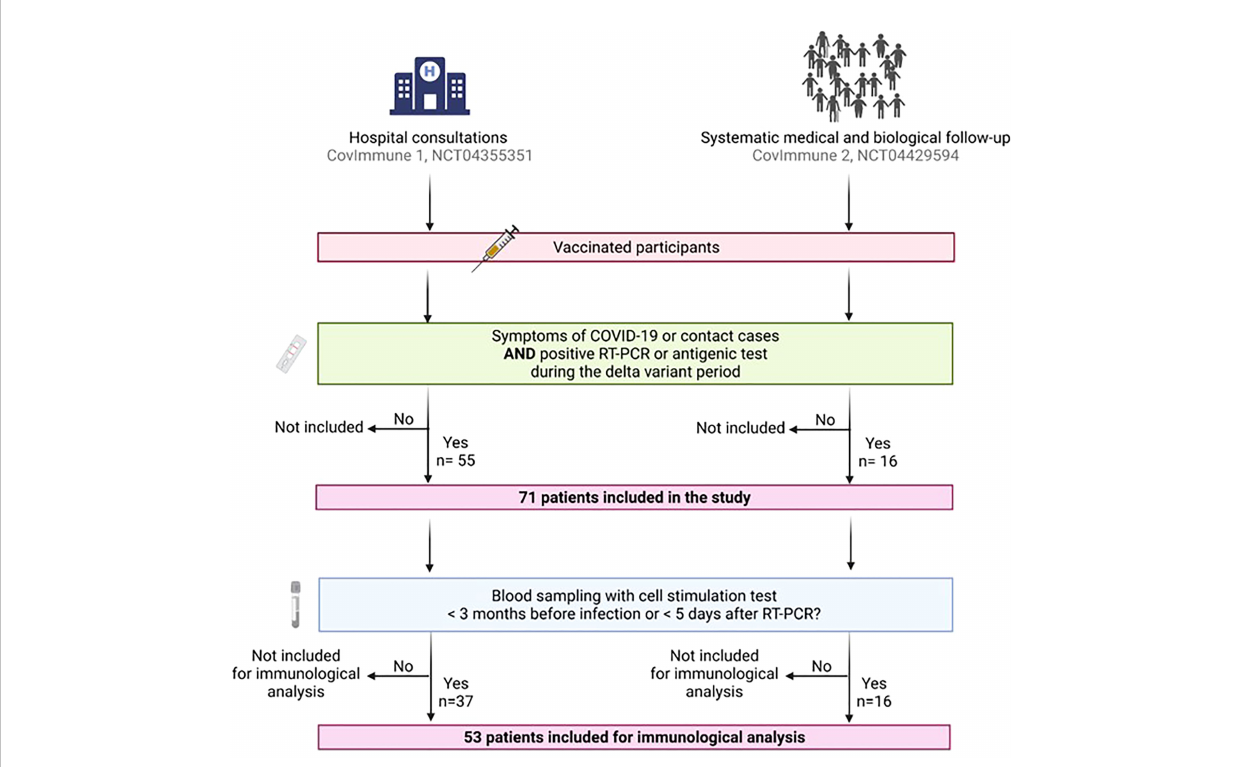
FIGURE 1 Flow chart showing participants inclusion. The participants were included from two cohorts: (i) patients recruited during a hospital consultation following COVID-19 symptoms, or as contact of a diagnosed COVID-19 case (CovImmune 1 study, NCT04355351); (ii) participants monitored periodically since July 2020 as part of an epidemiological study in the context of COVID-19 (CovImmune 2 study, NCT04429594) and developing a SARS-CoV- 2 infection. Patients were eligible for inclusion if they received a complete vaccination regimen, and they developed a SARS-CoV-2 infection in the aftermath of the vaccination and during the Delta variant period. Of these 71 patients, 53 could be included for immunological analysis because they had the necessary blood tests at the time of inclusion. COVID-19, coronavirus disease 2019; RT-PCR, reverse transcription- polymerase chain reaction. Created with